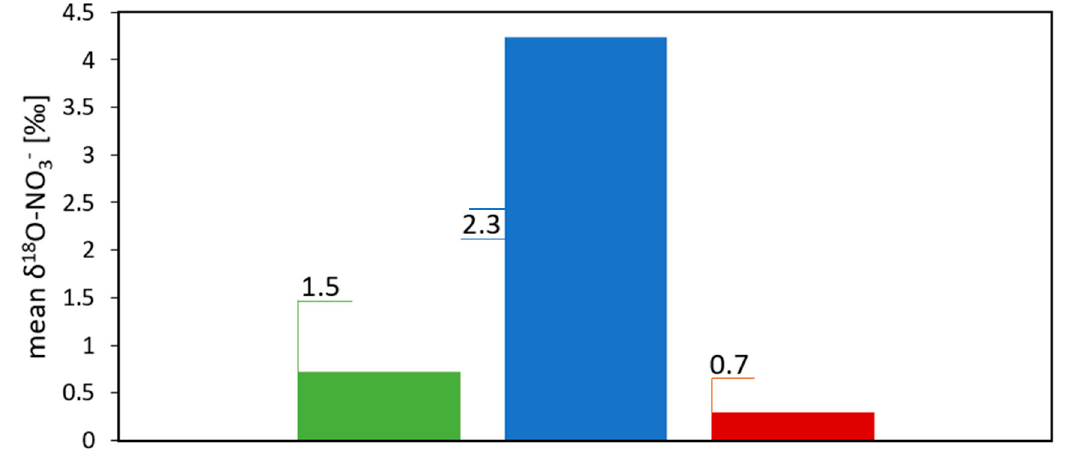
Figure 4. Focusing on a specific section of California’s Central Valley, centered around Fresno, three subgroupings of samples were chosen. Samples across several crop types are shown with yellow symbols (n = 25), samples in the undeveloped Sierra foothills with purple symbols (n = 15), and samples in a developed urban area with gray (n = 26). Shown also are average nitrate concentrations and isotopic ratios across the three defined land-use categories. [NO 3 − ] and δ 18 O-H 2 O follow expectations for higher nitrate loading, and use of imported river water for irrigation, respectively, by farmland.